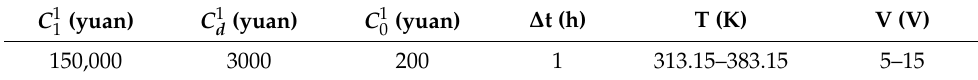
Table 16. Test cost and stress range.